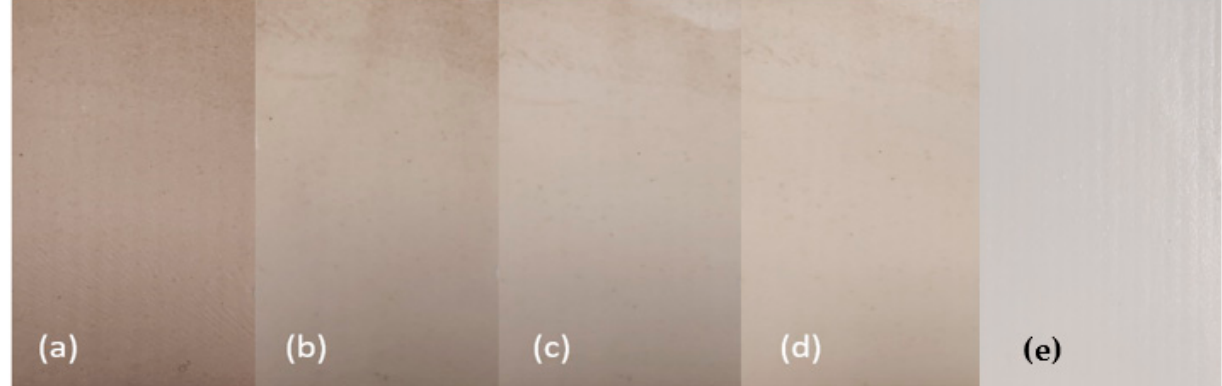
Figure 3. Membrane surface cleaning in demineralized water in the solar simulator. Pictures taken by conventional photography of the surface: ( a ) fouling color after 6 h of UWWTP effluent filtration, ( b ) after 1 h, ( c ) 2 h and ( d ) 3 h of irradiation, and ( e ) fresh membrane surface.